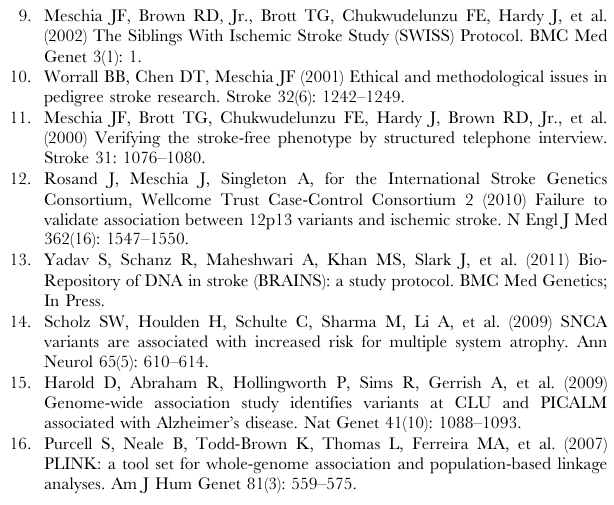
Table S1 Single nucleotide polymorphisms with the strongest associations for srtoke.